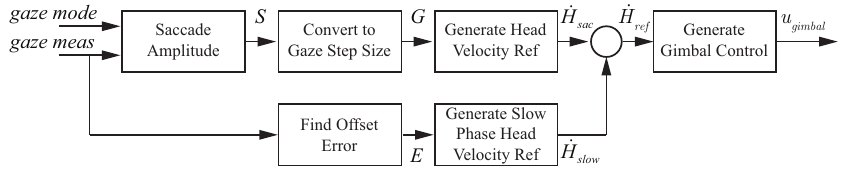
Figure 23. Block diagram showing the configuration of the saccade and fixation gimbal